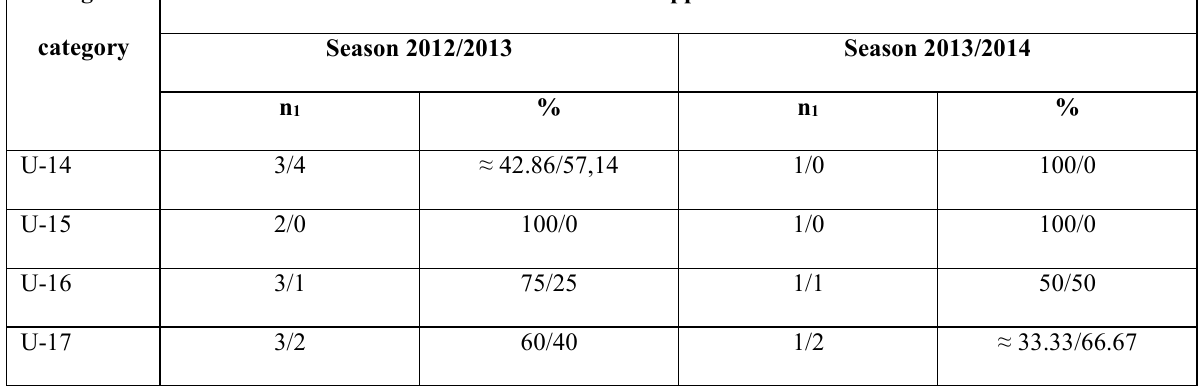
Indicators of correlation of upper and lower limbs’ traumas of CJSS FC “Metallurg” (Zaporozhye) football players in seasons 2012/2013 and 2013/2014 in performances in children-junior football league of Ukraine, ,